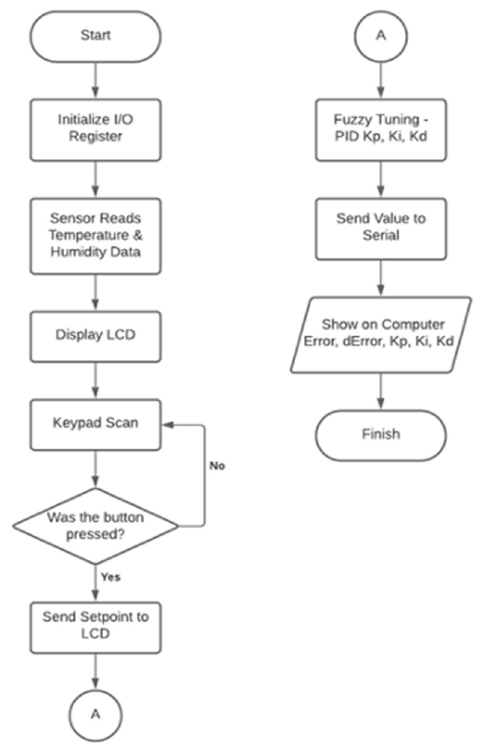
Figure 1. Research method and steps of Fuzzy-PID Hybrid control system on baby incubator.